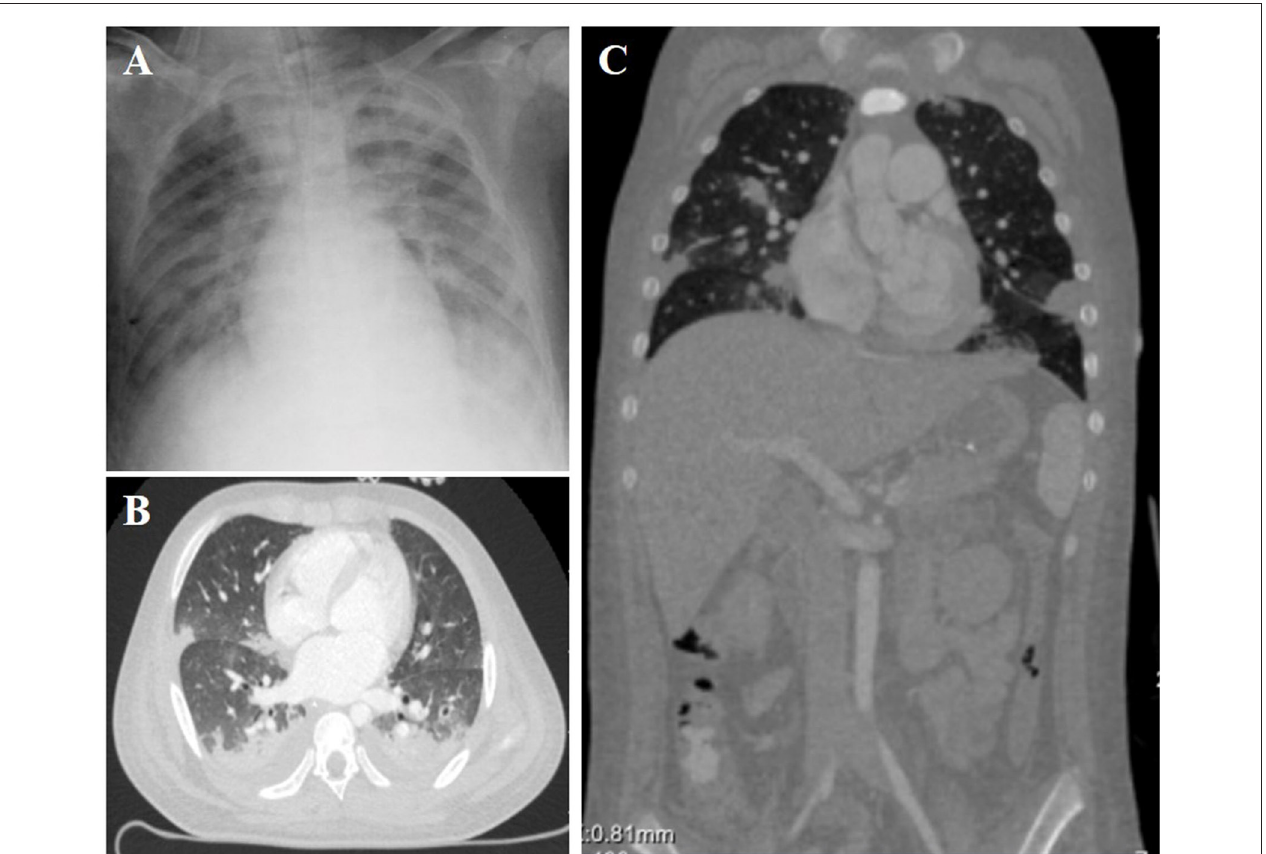
FIGURE 1 | Chest X-ray (A) and Contrast-enhanced computed tomography (B,C) showed mild cardiomegaly, interstitial pulmonary edema, and bilateral pulmonary